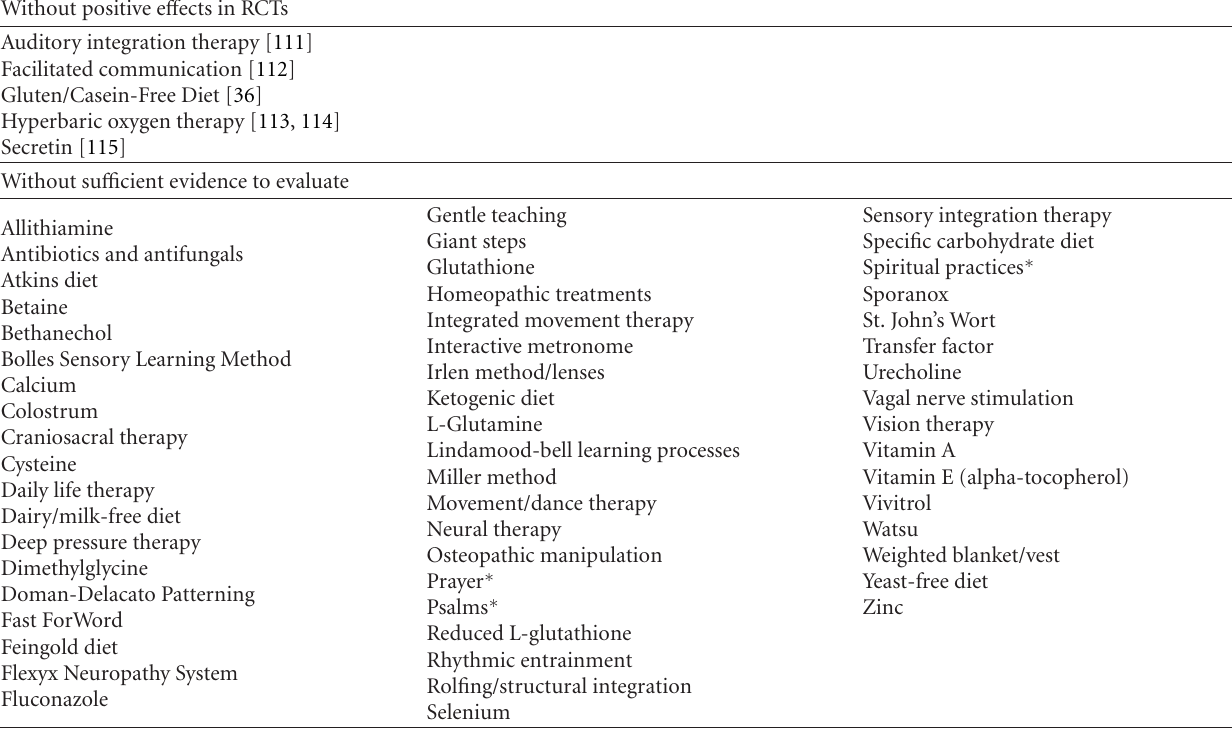
Table 4: Complementary and alternative treatments for autism spectrum disorders either without positive e ff ects in randomized control trials (RCTs) or without su ffi cient evidence to evaluate (listed